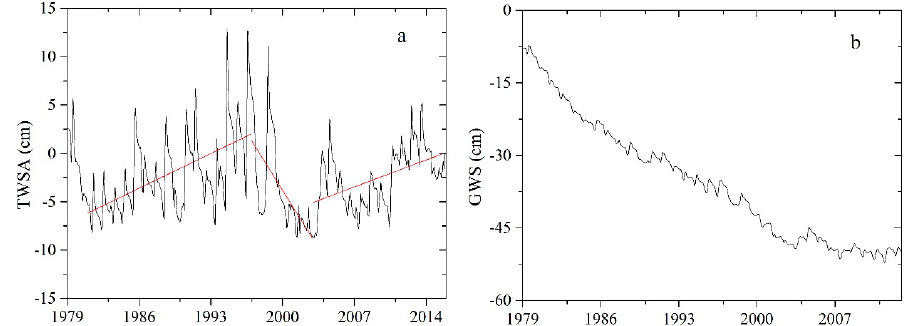
Figure 3. Variation patterns of TWSA and GWS in the Jing-Jin-Ji region. ( a ) changes of monthly TWSA from 1979 to 2010s, where red lines indicate linear fitting results of three various stages; ( b ) changes in monthly GWS from 1979 to the 2010s.